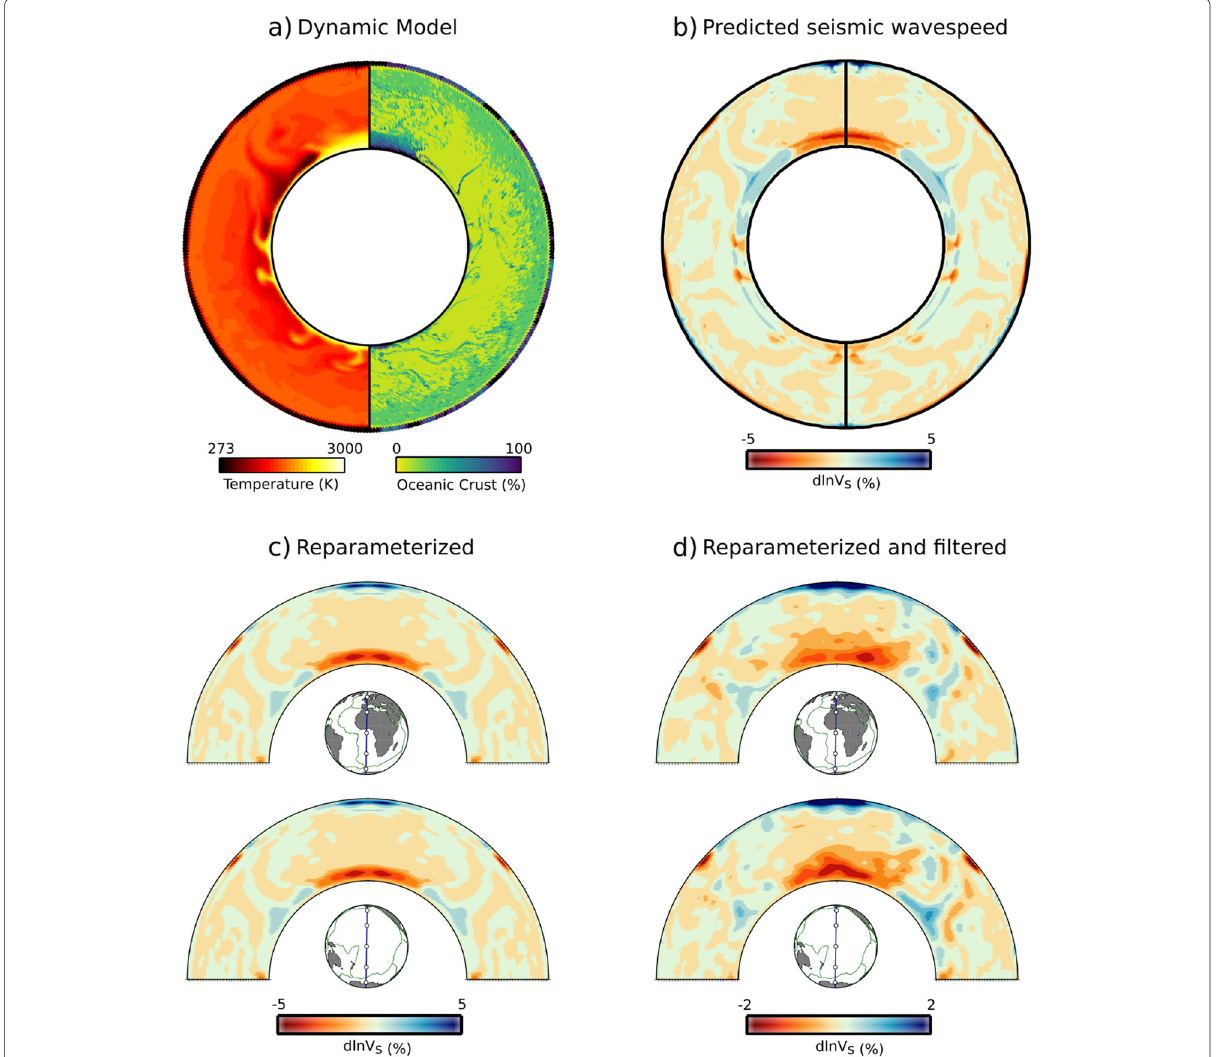
Fig. 3 Illustration of steps in our method to convert dynamic models into seismic velocity models and account for the parameterization and resolution of S40RTS. a Dynamic model, where δ ln ρ =3.8%, showing temperature and composition fields. b Predicted seismic wavespeed model showing δ lnV s variations with respect to the radial average. c Reparameterized model of δ lnV s on the basis of S40RTS. d Recovered δ lnV s after accounting for damping and uneven sampling of S40RTS. The geographic location of depth slice is provided in by the black vertical line through the